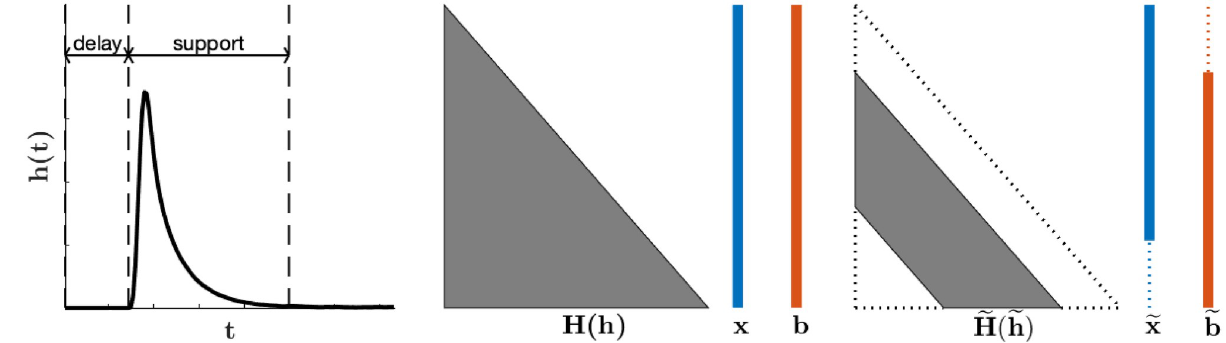
Fig 1. Illustration of the delay and support of the impulse response function h ( t ) used in respirometry. The middle and right plots demonstrate the change in structure from the original system in (1) to the reduced system in (4) that occurs due to the inclusion of delay and support assumptions.